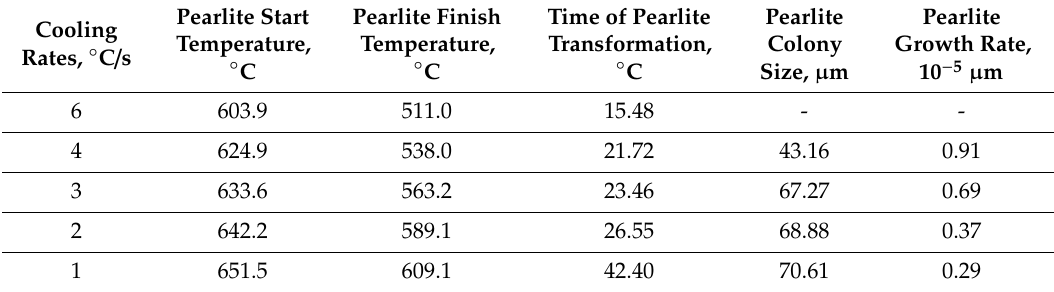
Table 1. Confocal scanning laser microcopy (CSLM)-based pearlite transformation characteristics at di ff erent cooling